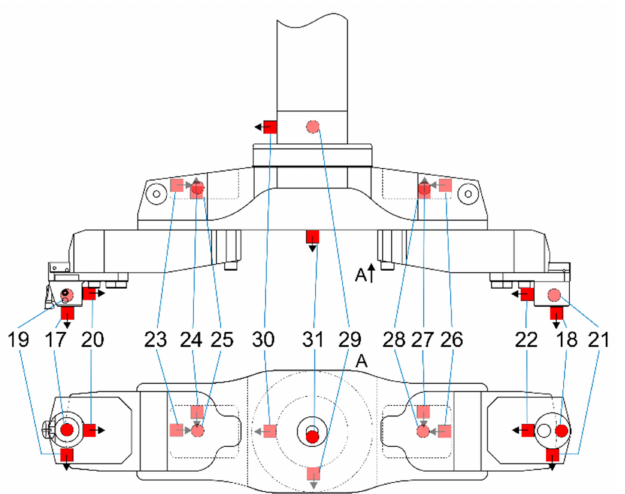
Figure 5. Scheme of the Sandvik CoroBore 825 XL boring tool with marked 1-axis accelerometers positions. Black arrows indicate the positive direction of measured accelerations. Accelerometers marked with a lighter color are covered by the object